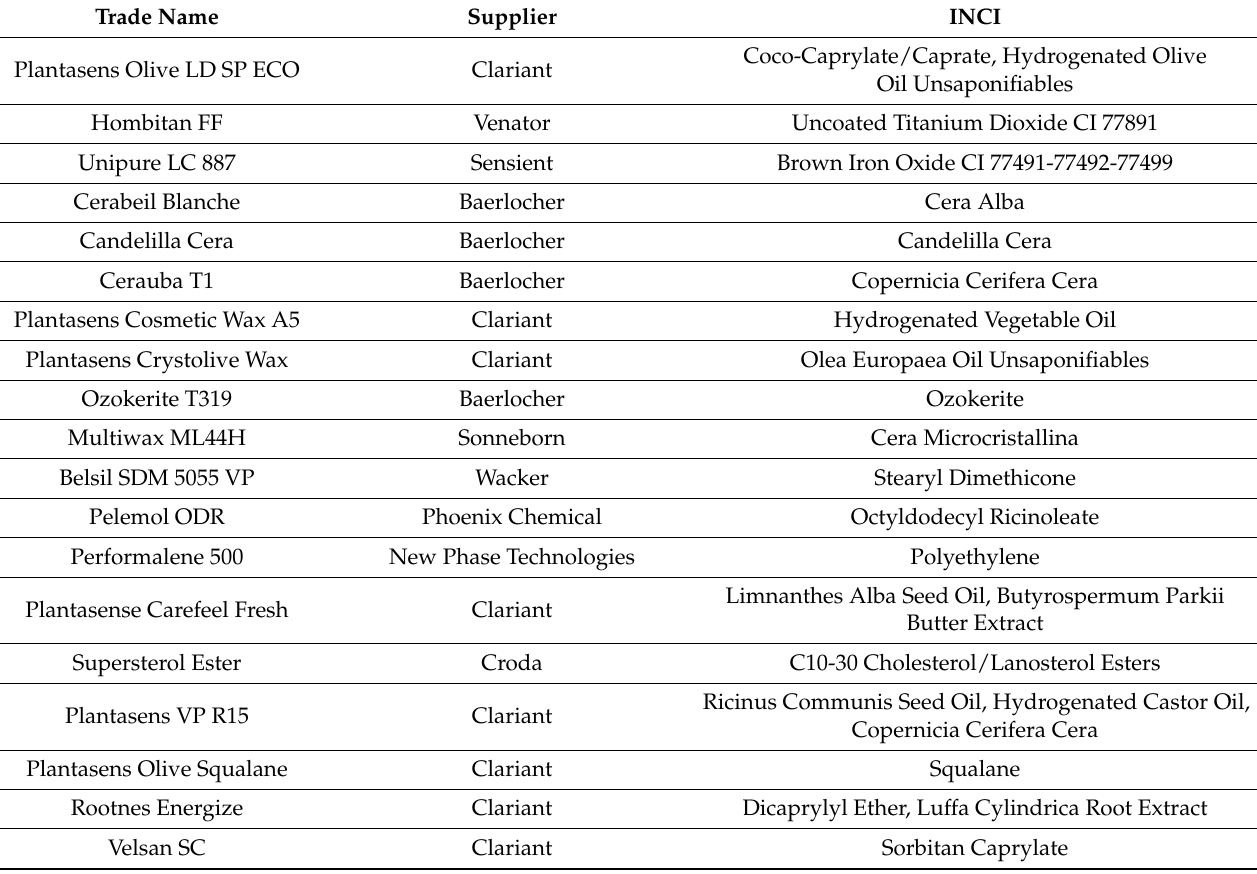
Table 2. Key raw materials, commercial names, suppliers, and INCI.